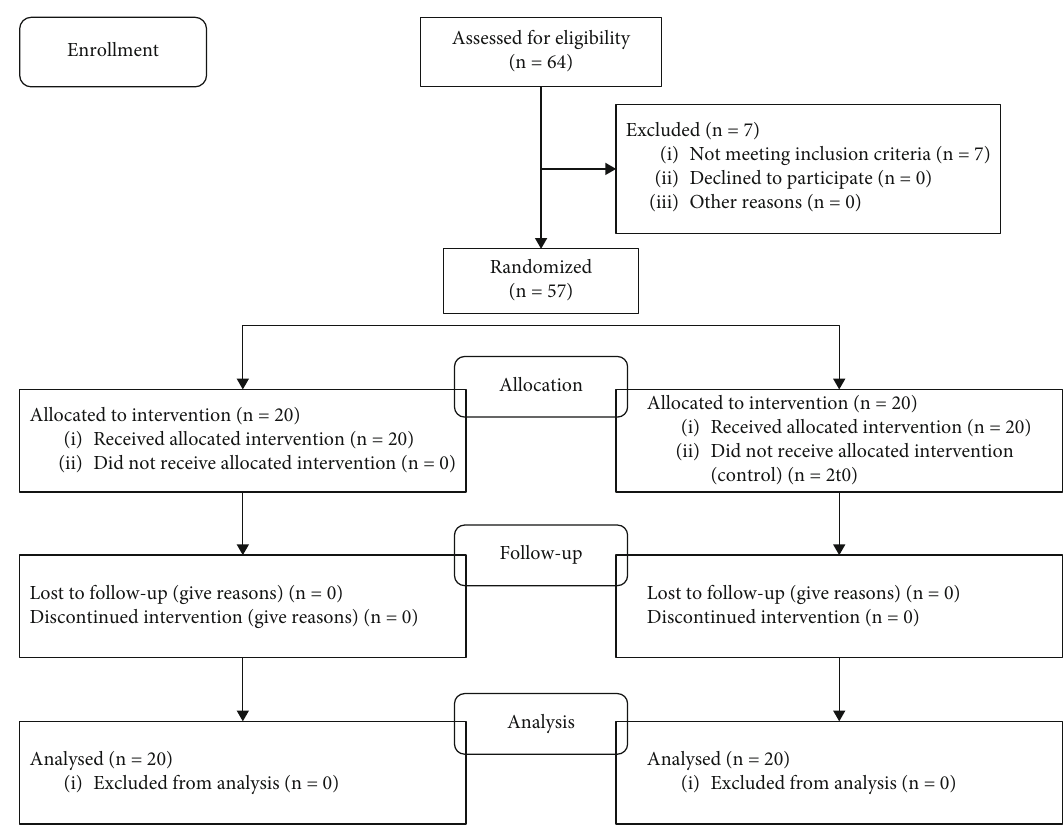
Figure 1: Flow diagram. Table 1: Comparison of eel cookies and cookies without eel composition/100